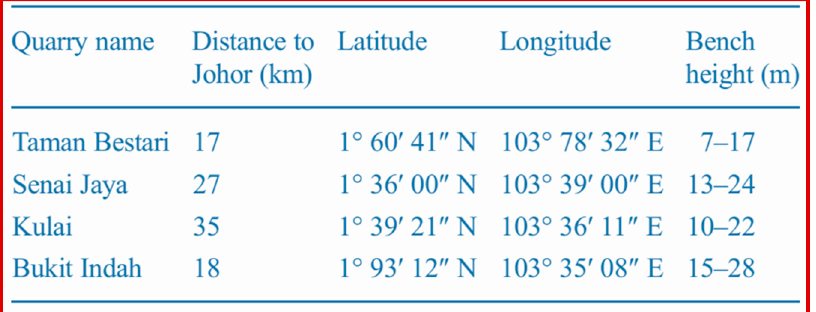
Figure 4. Kernels’ formula.